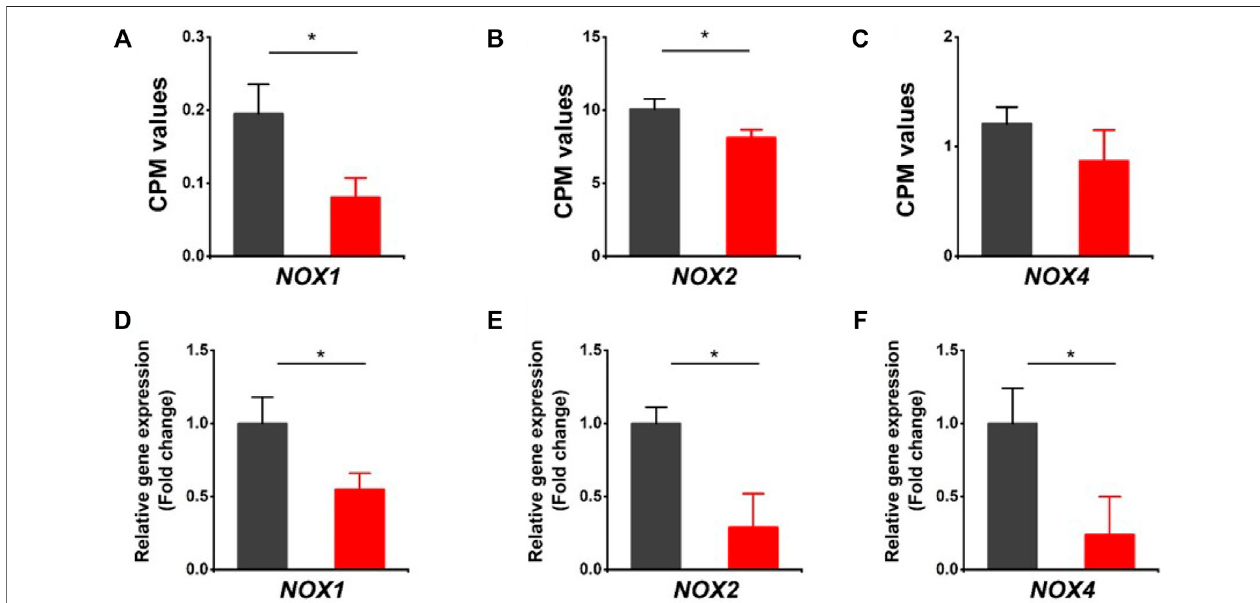
FIGURE 2 | Downregulation of the NOX family of ROS-generating NADPH oxidases in HVCN1 − / − hearts. Comparing relative gene expression levels of NOX1 , NOX2 , and NOX4 between WT (black) and HVCN1 − / − (red) detected by RNA-seq (A-C) and qPCR (D-F) . n = 4 independent experiments for RNA-seq; n = 3 independent experiments for qPCR; * p <